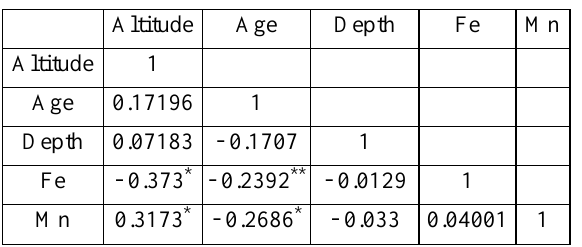
Table 15. Pearson’s correlation